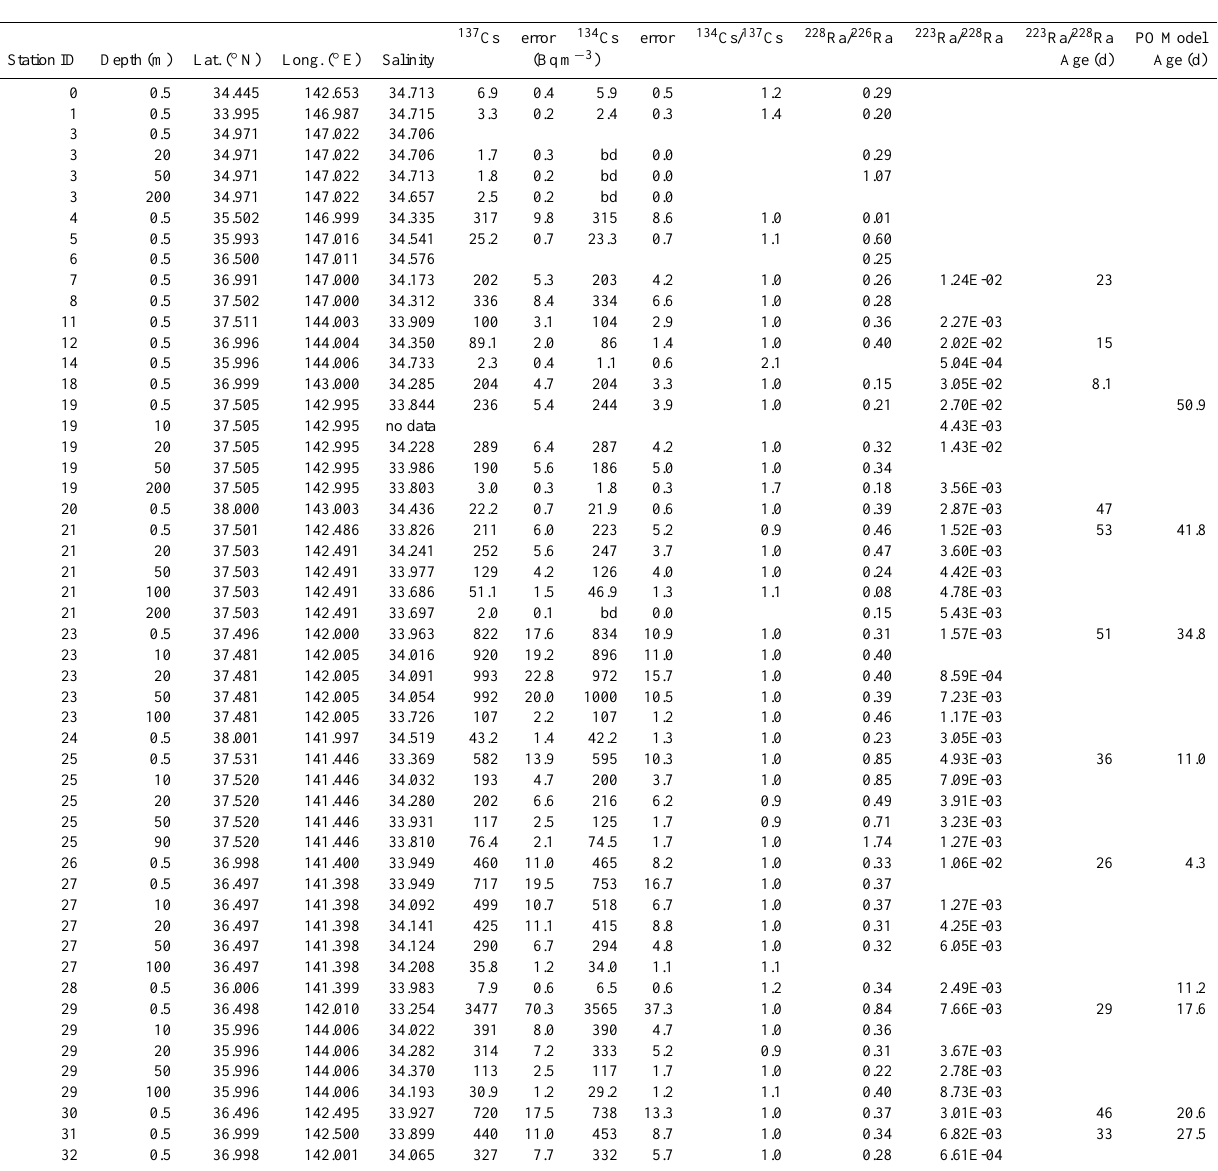
Table 2. Radium and Cs isotopes for stations were MnO 2 acrylic cartridges were